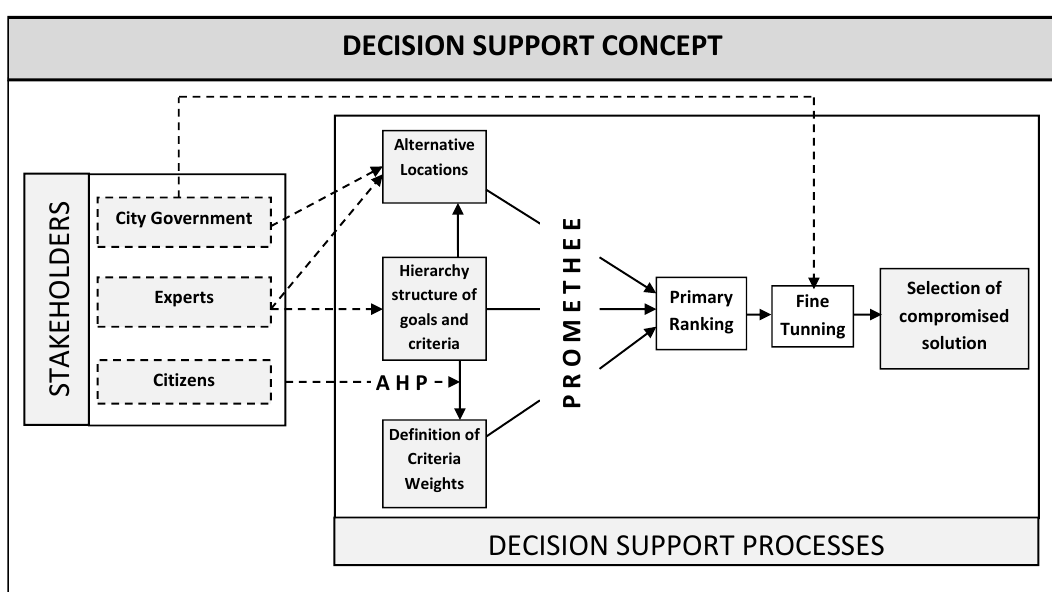
Figure 1. Decision support concept for location selection of wastewater treatment plants.